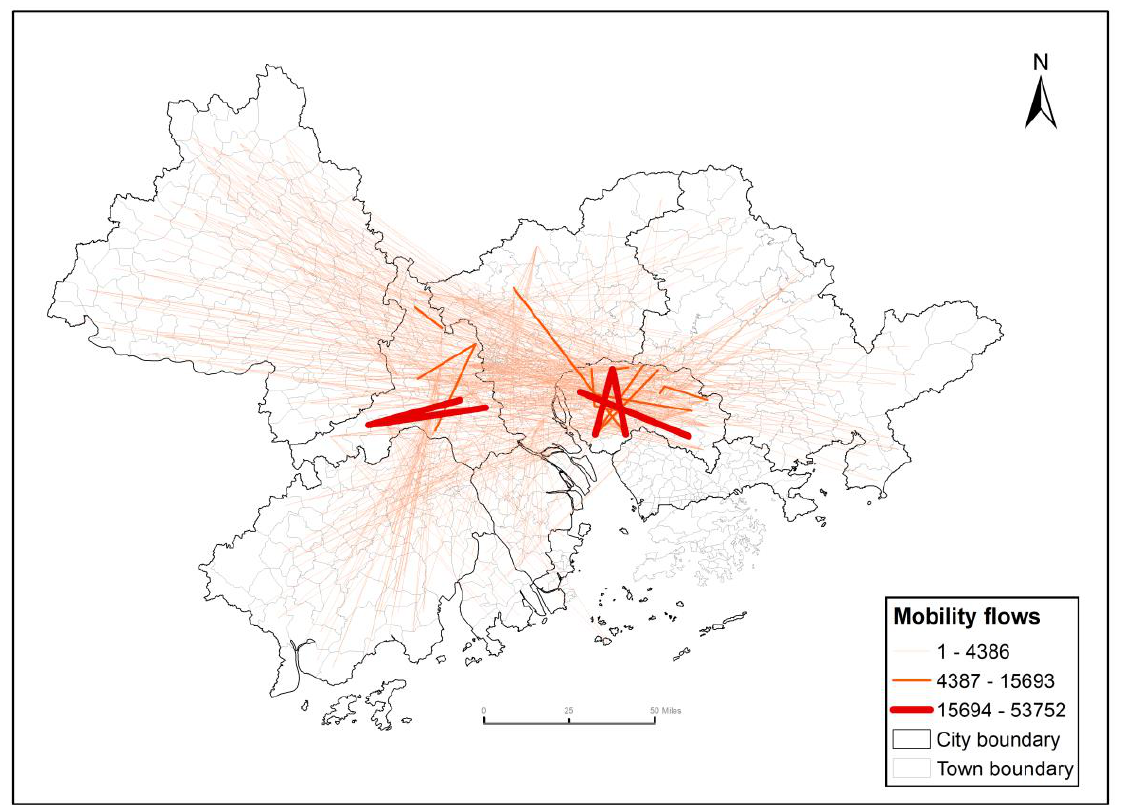
Figure 2. Population flows occurring between rural towns to be analyzed.